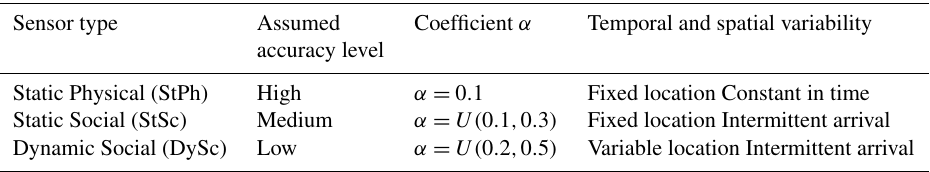
Table 2. Assumptions behind the observational errors (based on Weerts and El Serafy, 2006, Rakovec et al., 2012, and Mazzoleni et al., 2017a) according to the sensor types used in this